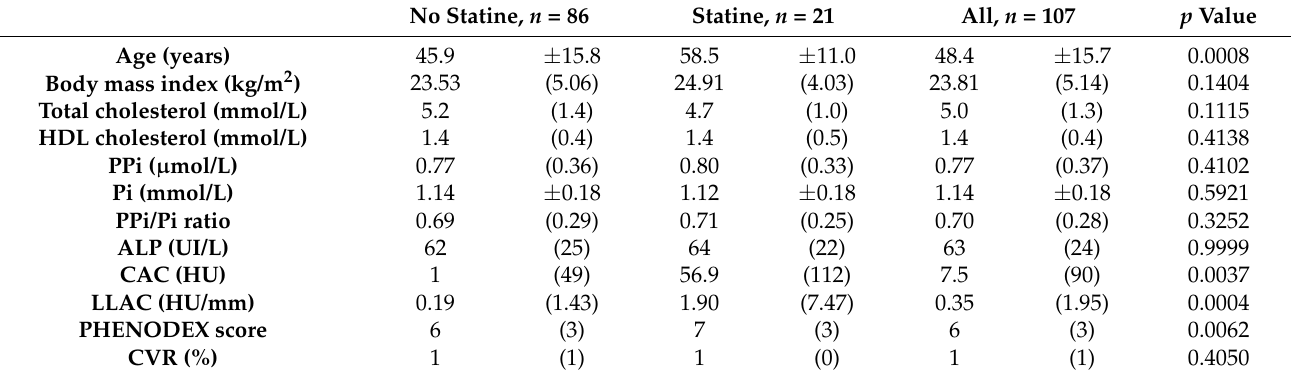
Table 3. Comparison between statine-treated and -untreated PXE patients. Data with a normal distribution are expressed as mean ( ± SD), others are expressed as median (interquartile). PPi: inorganic pyrophosphate; Pi: inorganic phosphate; ALP: alkalin phosphatase; GFR: glomerular filtration rate; CAC: Coronary arterial calcification; LLAC: Lower limb arterial calcification; CVR: 10 years—Cardiovascular Risk score.